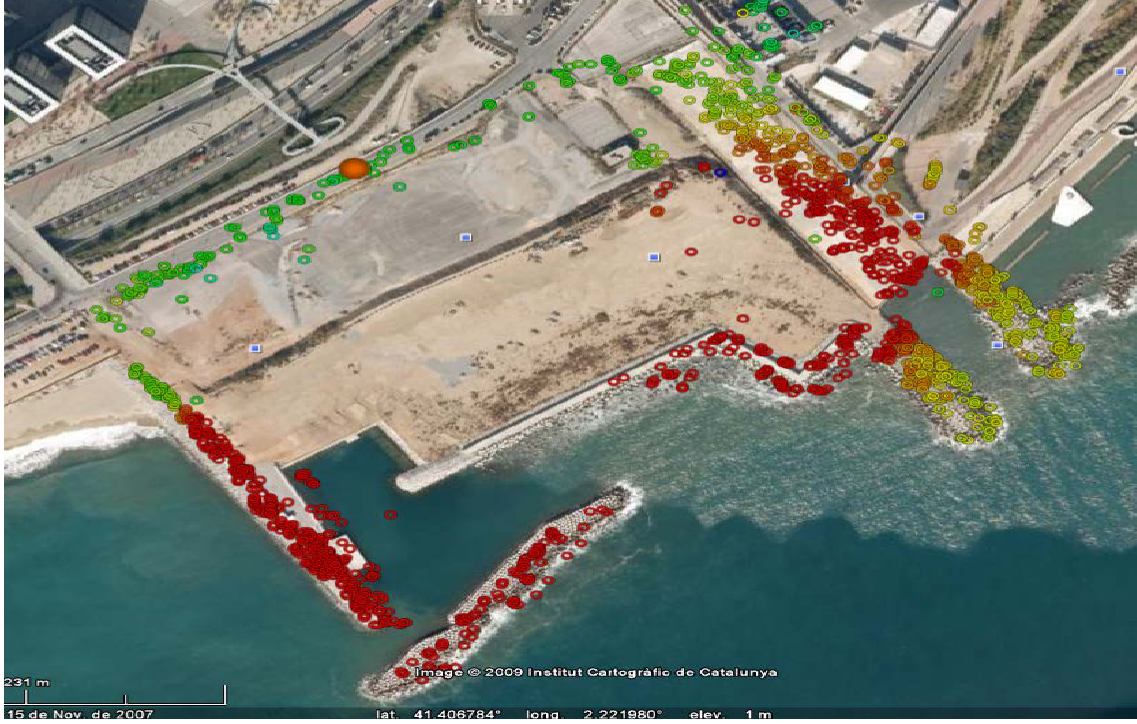
Figure 2. Example to show the high-resolution capability of PSI. This result was obtained using the PSI chain of CTTC and using very high-resolution SAR data from the TerraSAR-X sensor, covering the city of Barcelona